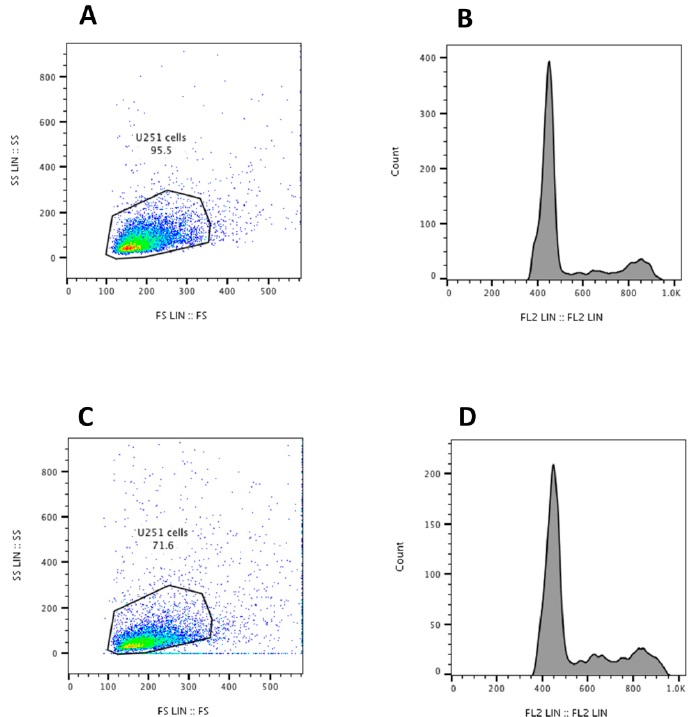
Figure 6. Flow cytometry analysis of not treated ( A , B ) or treated ( C , D ) U251 cells with UiO-66_N (30 µ g/mL) for 48 h. Left panels represent dot plot of not treated ( A ) and UiO-66_N treated ( C ) live U251 cells (gated inside the dot plot). Events outside the gate of U251 cells in UiO-66_N-treated group are mostly MOF aggregates. Right panels represent propidium iodide staining showing cell cycle profiles. No significant differences between not treated ( B ) and UiO-66_N treated ( D ) cells were detected.